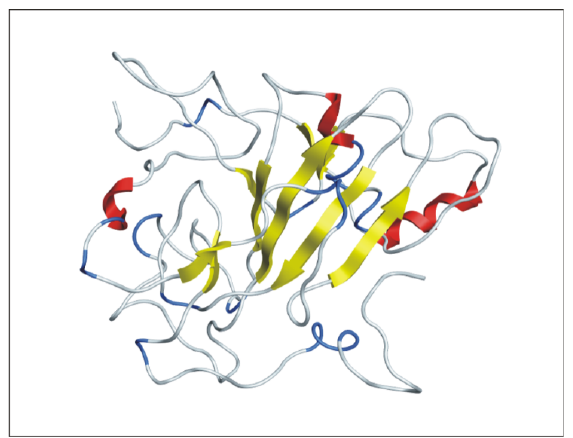
Figure 1. V Protein: 3-dimensional model showing three α -helices, eight β -pleated sheets, and ten coiled regions in red, yellow, and white colors respectively.